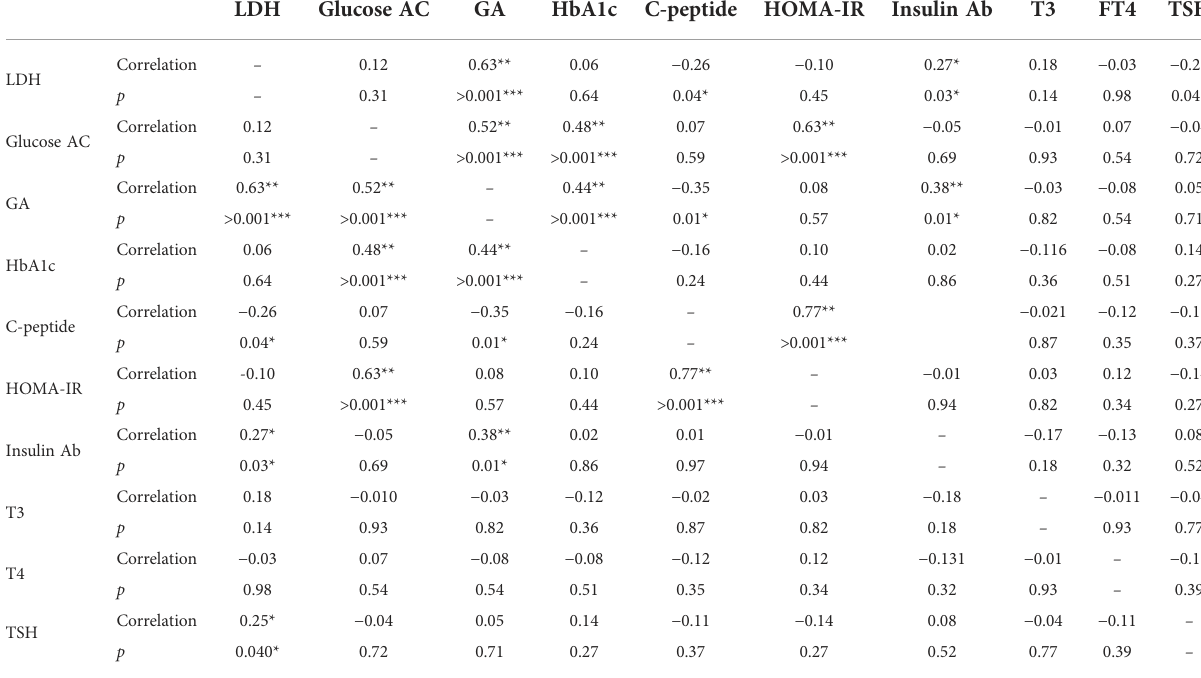
TABLE 2 The correlation of serum LDH levels with other diabetes-related hematological markers.